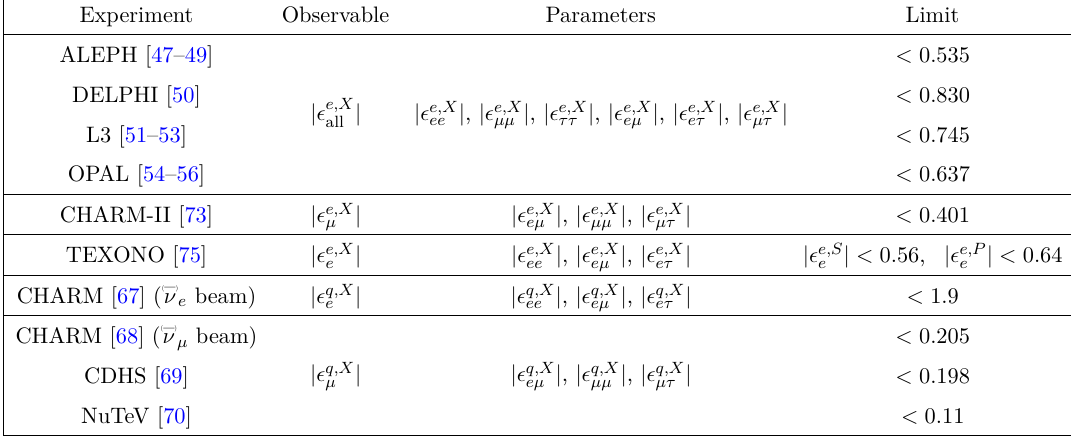
Table 4 . Exclusion 90% C.L. limits on the observable scalar and pseudoscalar neutrino interaction parameter for different experiments, with X = S, P . Both scalar and pseudoscalar limits are the same for all experiments except for TEXONO (see section 2 for a detailed